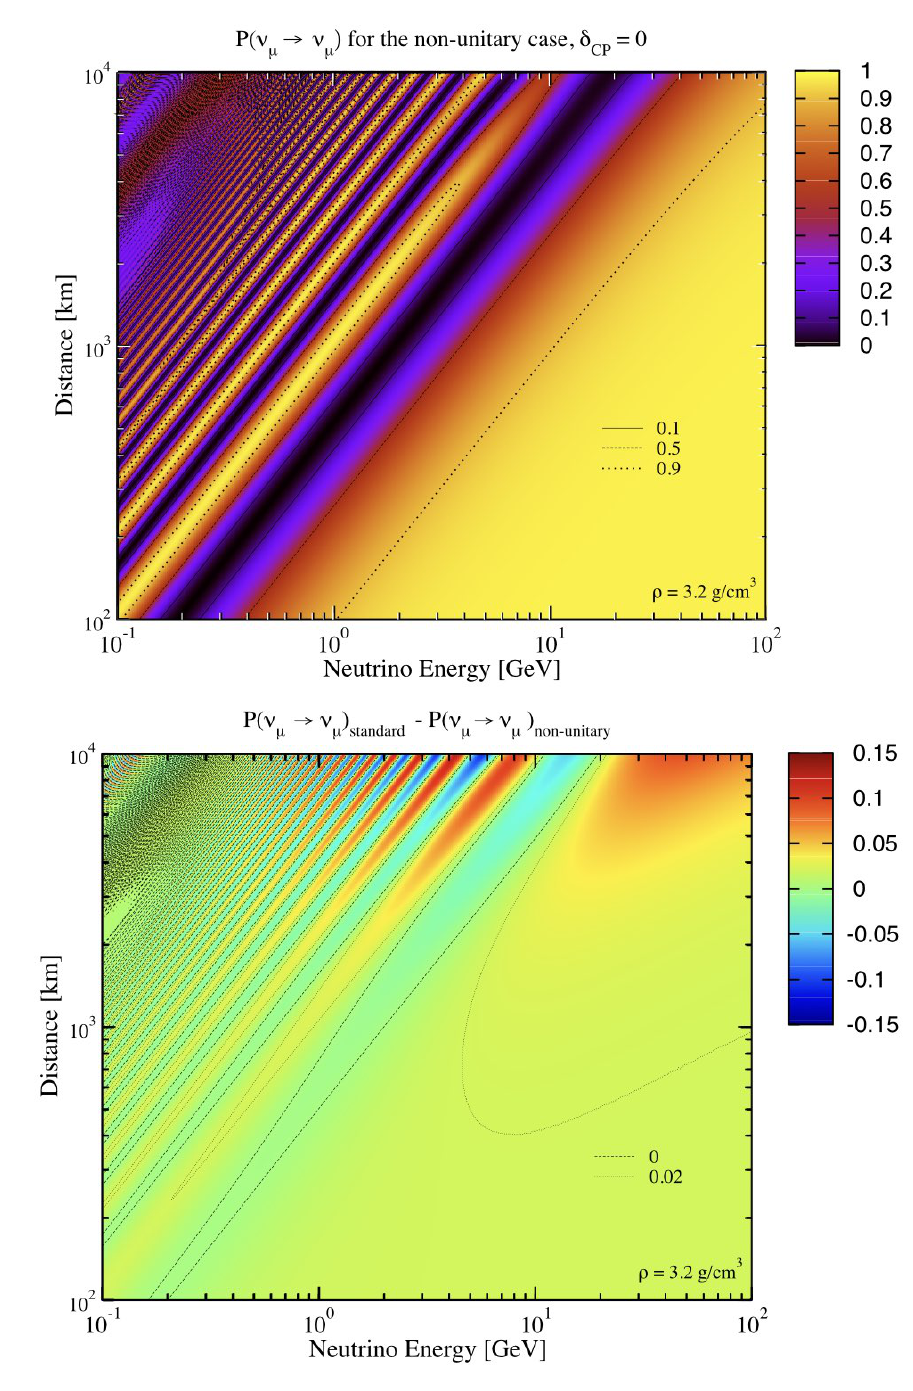
Figure 3 . In the upper panel (a), presented is the iso-contour of P ( (cid:23) (cid:22) ! (cid:23) (cid:22) ) (0) space. In the lower panel (b), the iso-contour of the di(cid:11)erence (cid:1) P ( (cid:23) (cid:22) ! (cid:23) (cid:22) ) (cid:17) P ( (cid:23) (cid:22) ! (cid:23) (cid:22) ) standard (cid:0) P ( (cid:23) (cid:22) ! (cid:23) (cid:22) ) (0) is presented. The parameters used are the same as in (cid:12)gure 1. non-unitary